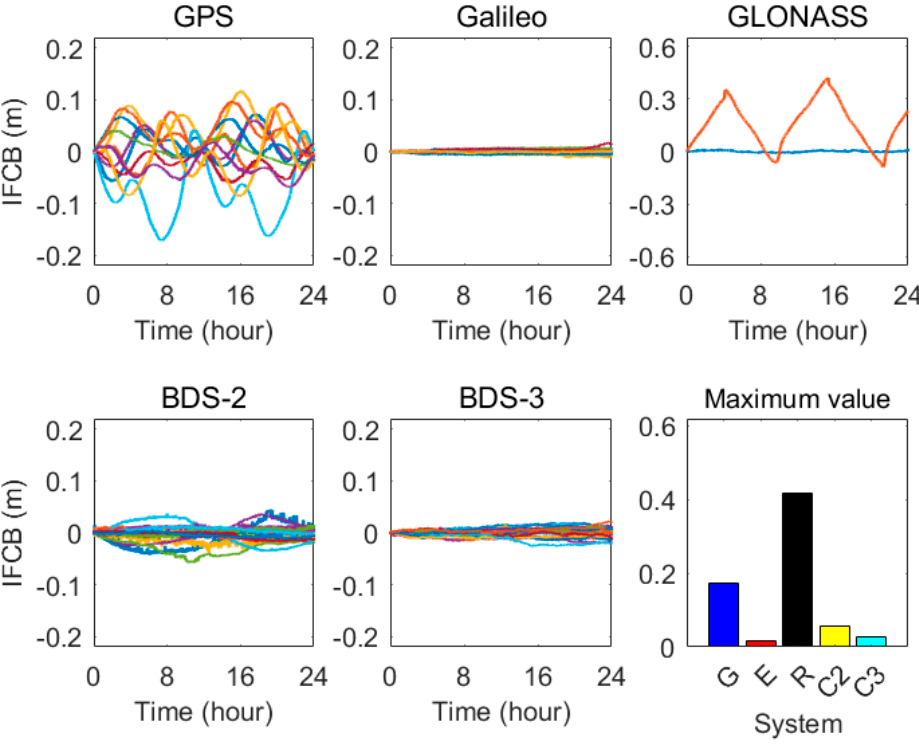
Figure 4. The multi-GNSS IFCB series and maximum values on DOY 290, 2021. A different color line represents a different satellite. The orange and blue lines of GLONASS denote R21 and R09 satellites, respectively. The abbreviation G, E, R, C2, and C3 represents GPS, Galileo, GLONASS, BDS-2, and BDS-3, respectively.